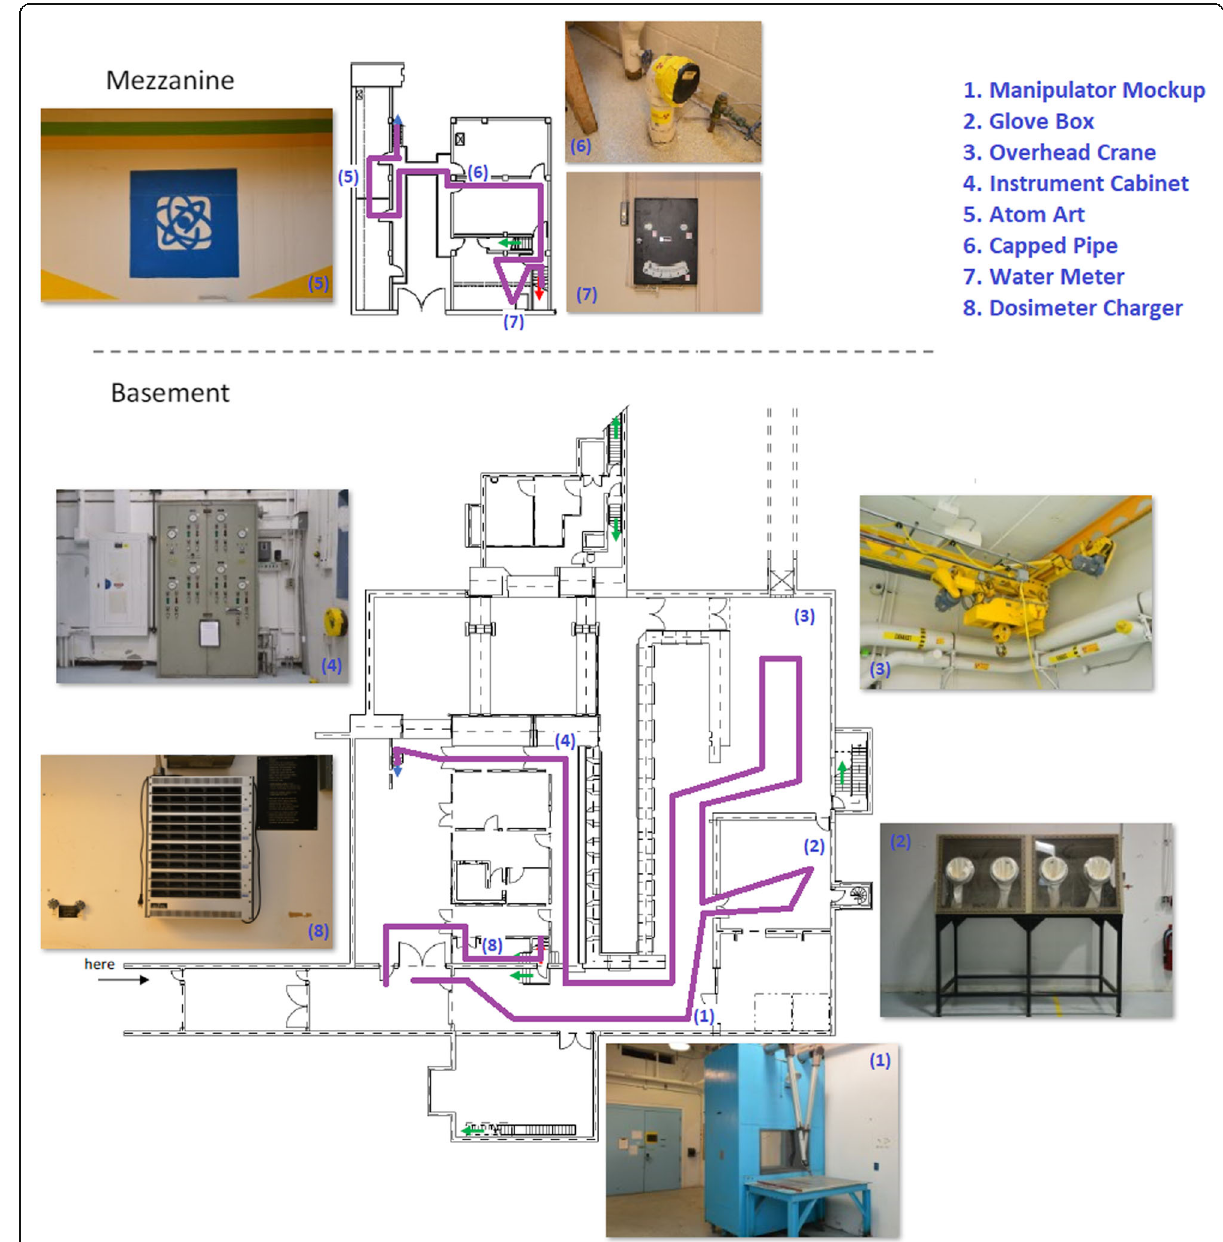
Fig. 1 The simple study map overlaid with a line indicating the learned route and photos of the target